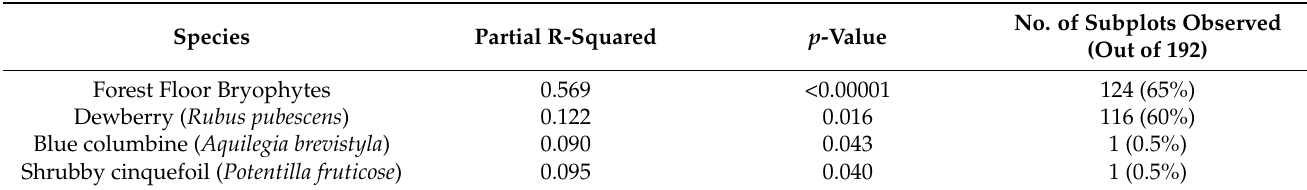
Table 3. Results of a stepwise discriminate analysis (SDA) on all plant species cover observed in this study.